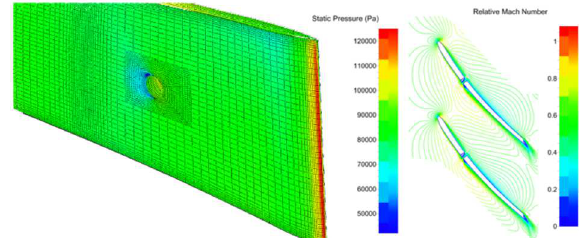
Fig. 6. Surface mesh and static pressure (left) and the relative Mach number (right) .